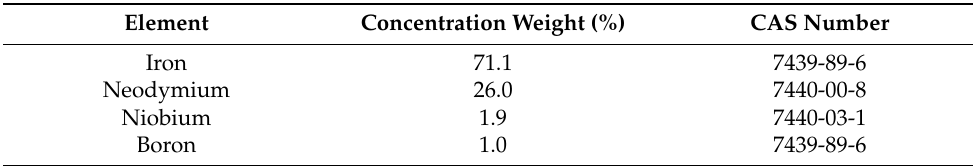
Table 1. Composition of MQFP-14-12